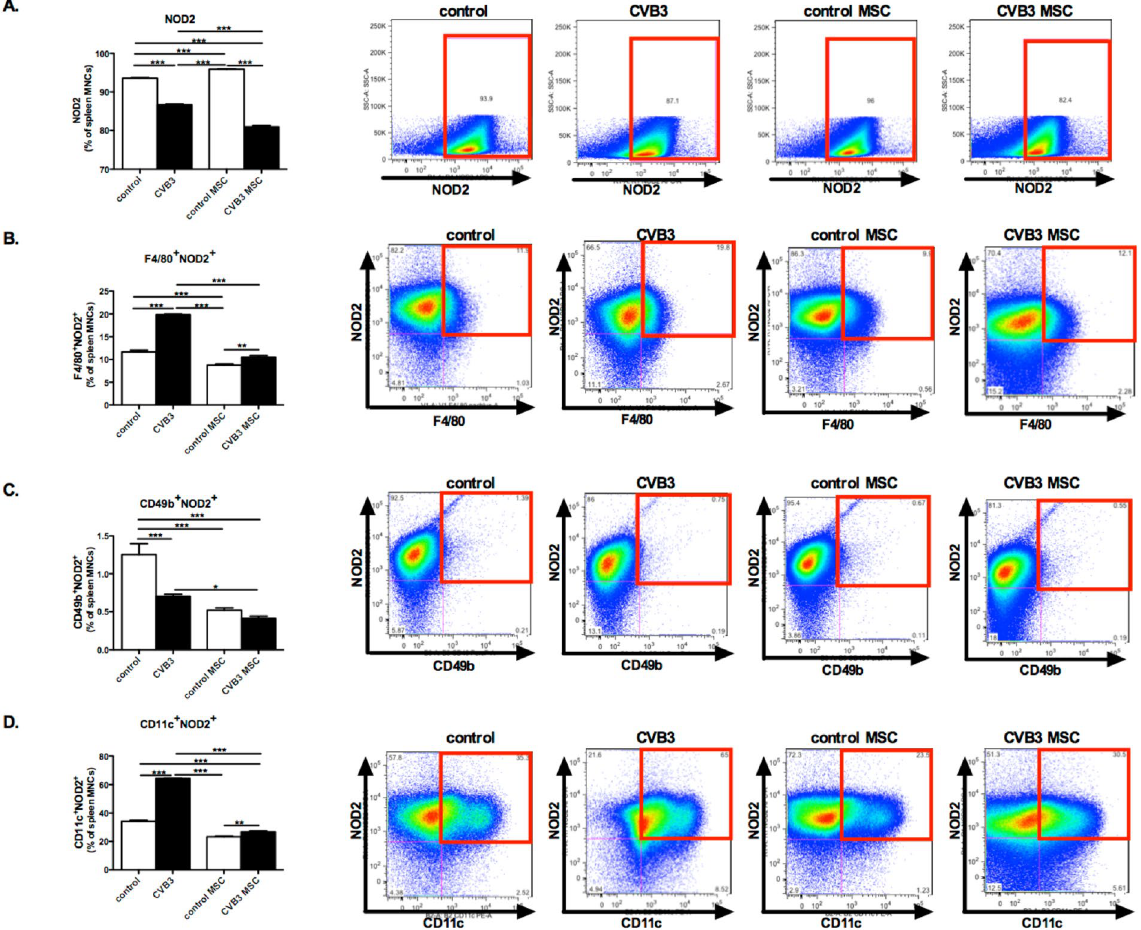
Figure 3. Mesenchymal stromal cells inhibit Coxsackievirus B3-induced NOD2 expression in macrophages, natural killer cells, and dendritic cells. ( A ) Bar graphs represent the mean ± SEM of NOD2-positive splenocytes in control mice (open bar) and CVB3-infected mice (closed bar) injected with PBS or MSC, expressed as the percentage of total MNCs, with n = 8–9/group. The right panel shows dot plots of NOD2 positive splenocytes of control, CVB3, control MSC, and CVB3 MSC mice, as indicated. ( B ) Bar graphs represent the mean ± SEM of F4/80 + /NOD2 + in control mice (open bar) and CVB3-infected mice (closed bar) injected with PBS or MSC, expressed as the percentage of total MNCs, with n = 8–9/group and ** p < 0.01. The right panel shows dot plots of F4/80 + /NOD2 + - positive splenocytes of control, CVB3, control MSC, and CVB3 MSC mice, as indicated. ( C ) Bar graphs represent the mean ± SEM of CD49b + /NOD2 + in control mice (open bar) and CVB3-infected mice (closed bar) injected with PBS or MSC, expressed as the percentage of total MNCs, with n = 8–9/group and ** p < 0.01. The right panel shows dot plots of CD49b + /NOD2 + -positive splenocytes of control, CVB3, control MSC, and CVB3 MSC mice, as indicated. ( D ) Bar graphs represent the mean ± SEM of CD11c + /NOD2 + in control mice (open bar) and CVB3-infected mice (closed bar) injected with PBS or MSC, expressed as the percentage of total MNCs, with n = 8–9/group and ** p < 0.01. The right panel shows dot plots of CD11c + / NOD2 + -positive splenocytes of control, CVB3, control MSC, and CVB3 MSC mice, as